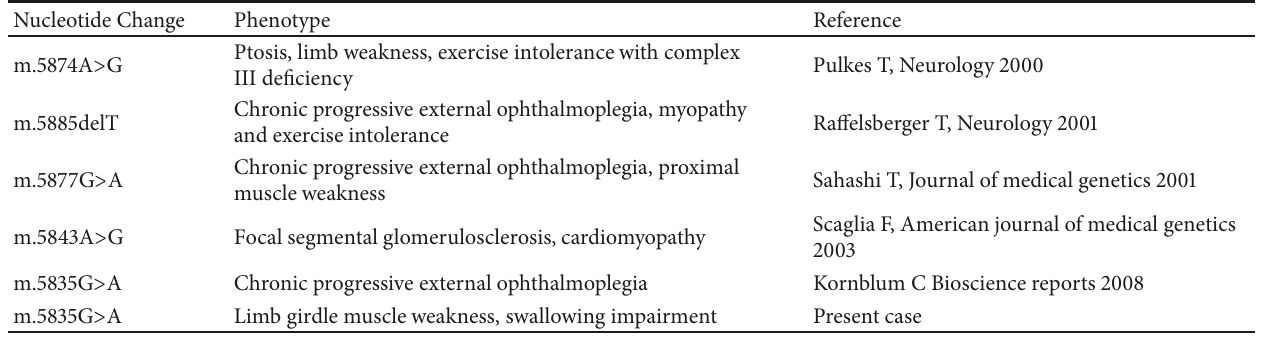
Table 1: Overview of the published cases with mitochondrial MTTY gene